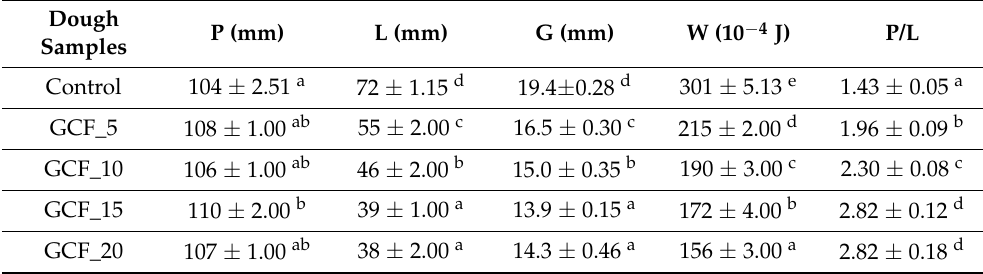
Table 2. Alveograph data of dough samples with different levels of GCF addition in wheat flour.